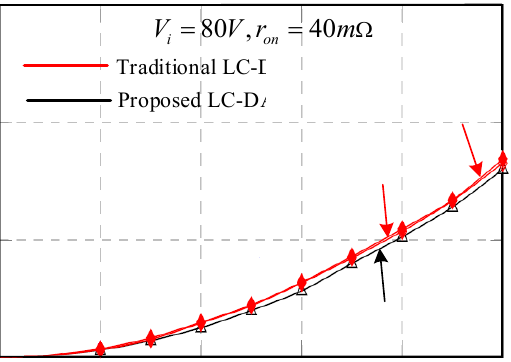
Figure 5. Conduction losses waveforms of two LC-DAB converters.